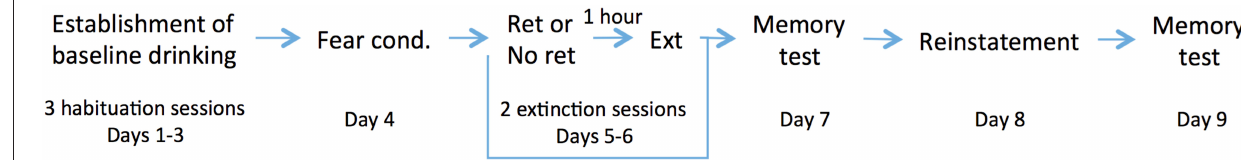
FIGURE 1 | Experimental timeline.